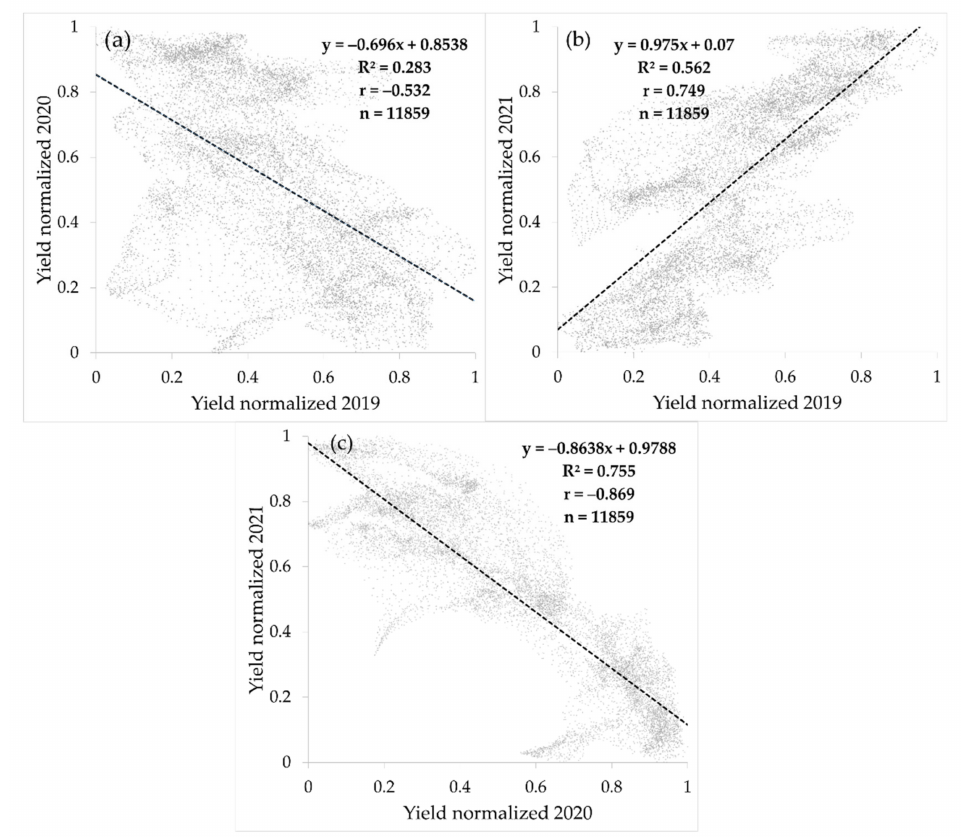
Figure 8. Correlation of normalized yield data between crops of 2019 and 2020 ( a ), 2019 and 2021 ( b ), and 2020 and 2021 ( c ).